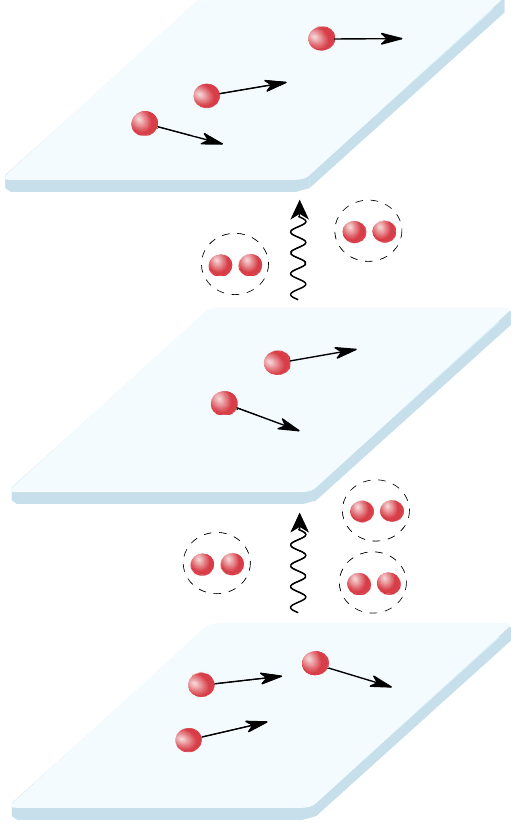
FIG. 1. A schematic representation of the difference between in-plane and interplane transport. In each QSL plane, the spinons are deconfined and may travel freely. However, transport between the planes is only possible via gauge-invariant excitations, such as spinon pairs.